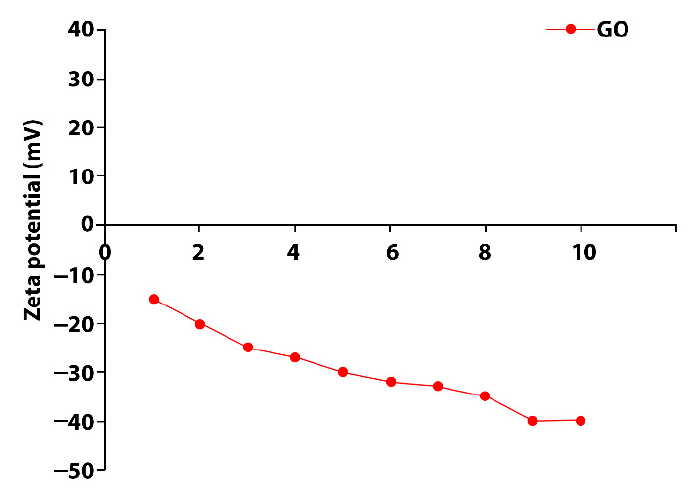
Figure 1. Zeta potential graphic of GO